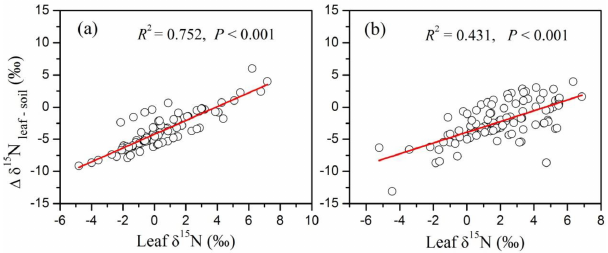
Figure 3. Relationships between δ 15 N leaf-soil and leaf δ 15 N on the north slope (a) and the south slope (b) of Tian